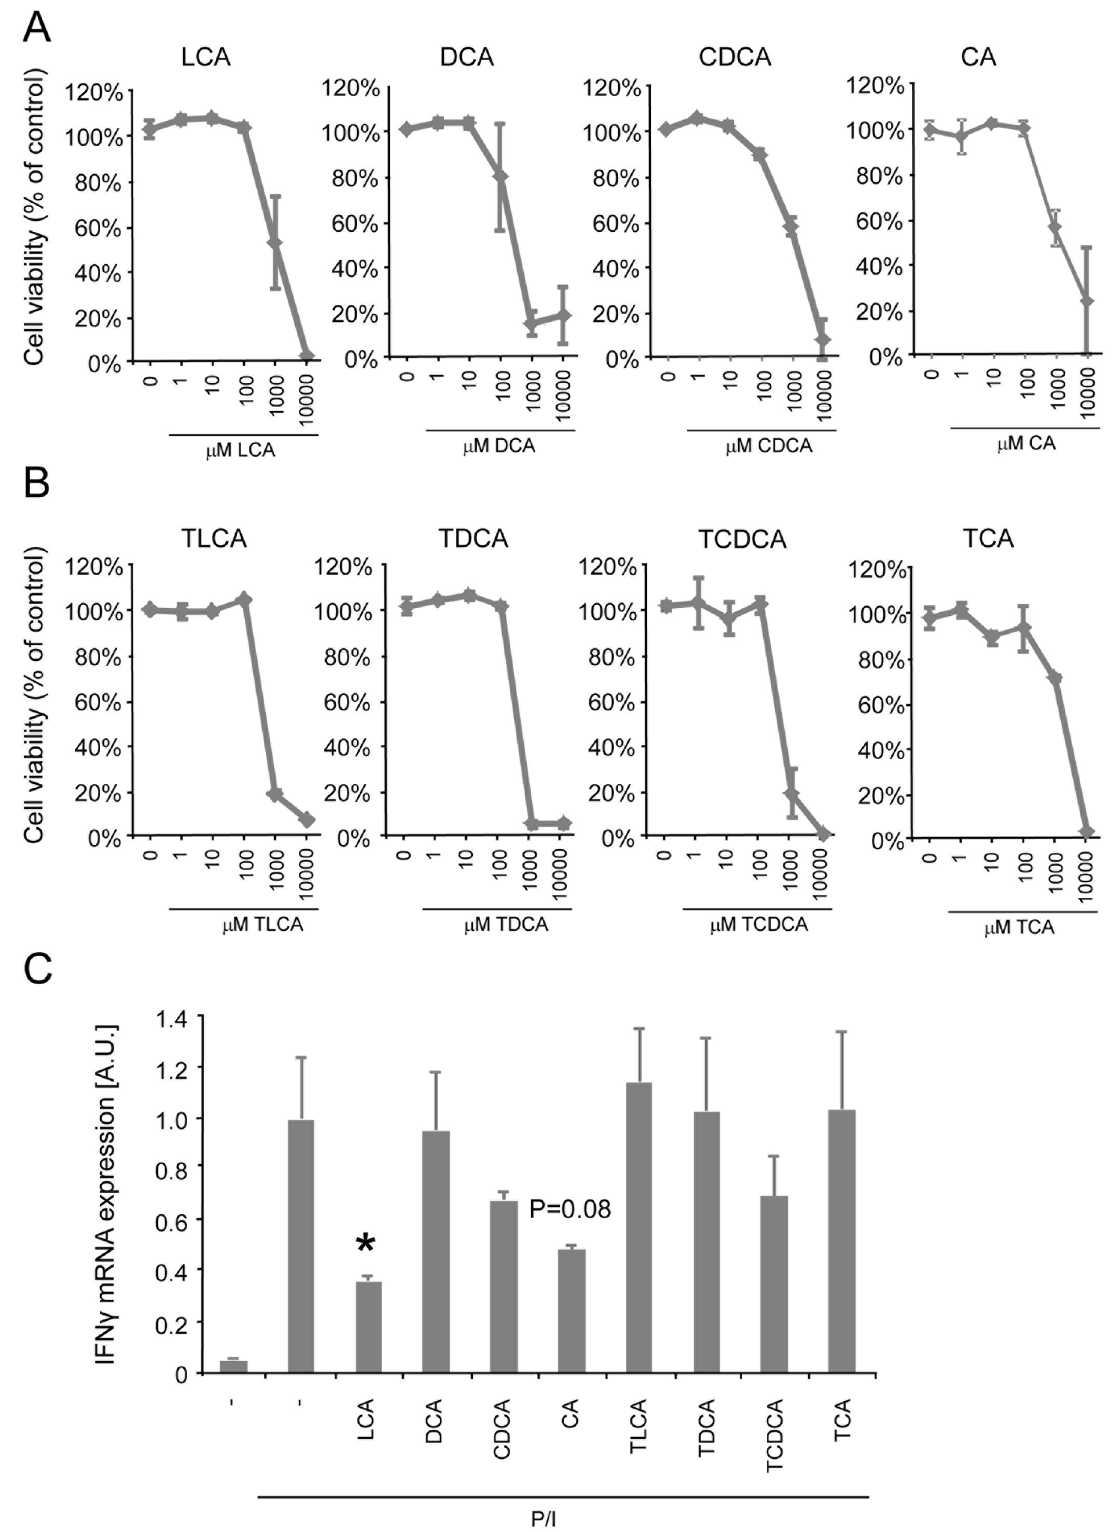
Fig 1. LCA inhibits IFN γ gene expressionin Jurkat T cells (A) Cell viability of Jurkat T cells measuredby flowcytometry analysisand expressedas percentageof control in response to incubationwith unconjugated bile acids and (B) taurine-